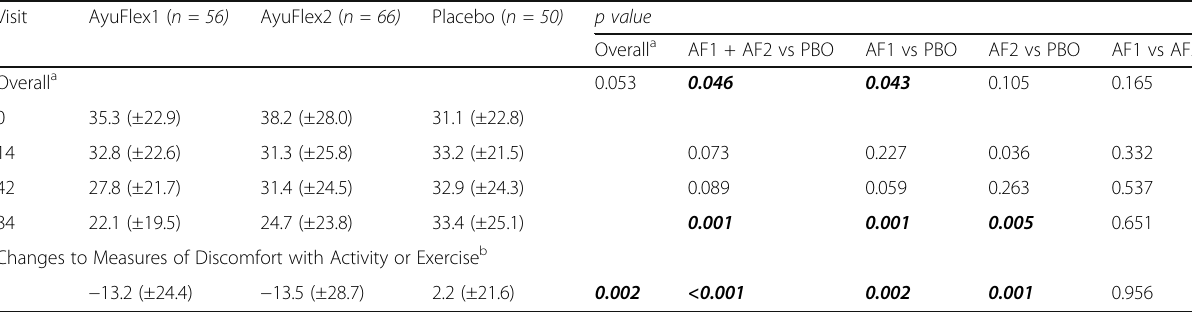
Table 5 VAS score of measure of discomfort with activity/exercise Visit